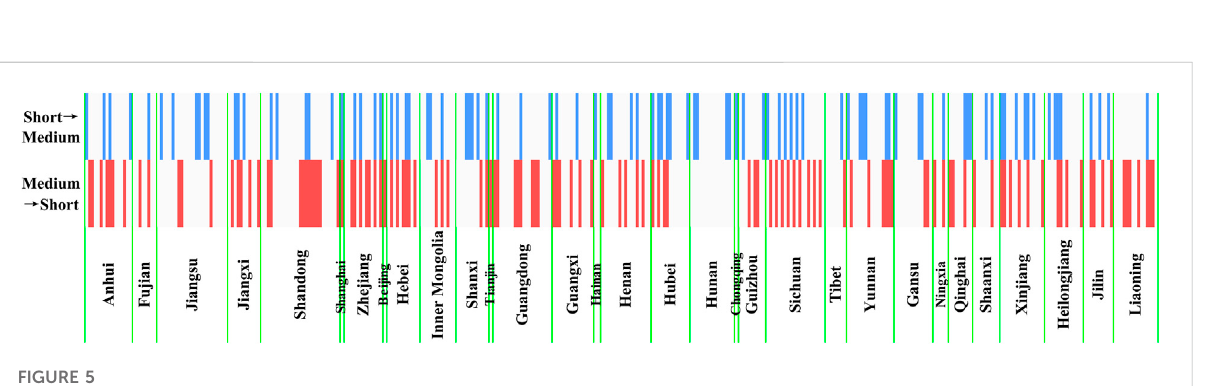
Lead-lag relationships in the Sis between the short and medium timescale for 358 Chinese cities in 31 provinces. The X-axis is the province where the city is located, and the Y-axis is the lead-lag relationship between the two timescales. Speci fi cally, the top bar code represents that the short-term spillover impacts are ahead of the medium-term spillover impacts, and the bottom bar code represents that the medium-term spillover impacts are ahead of the short-term spillover impacts. A blue or red narrow bar is displayed if there is a lead-lag relationship, and a light